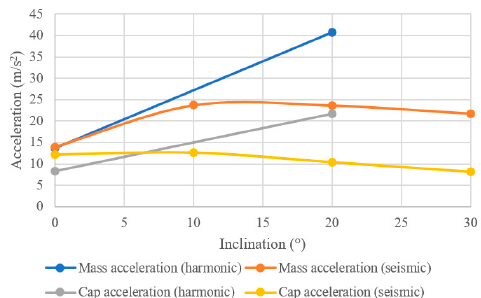
Figure 5. Soil–MPs–structure response with different inclination angles (compilation after [13]).